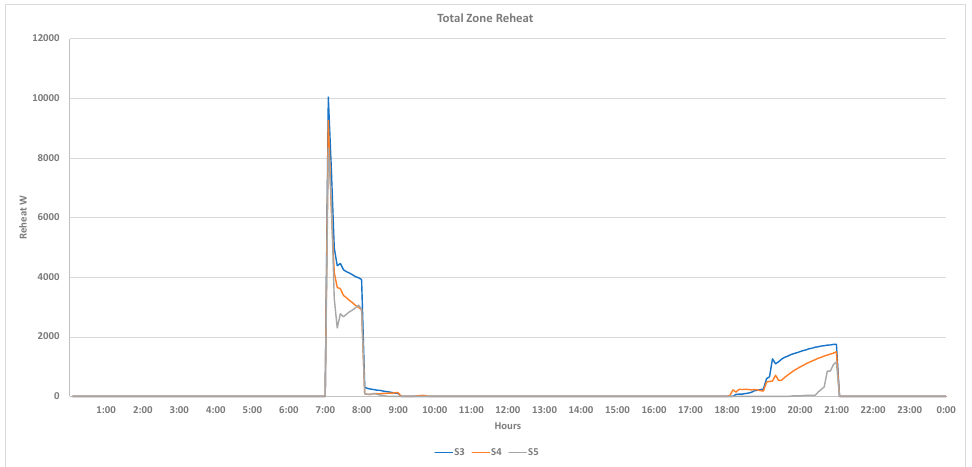
Figure 5. Total zone reheats when the strategies S3, S4, and S5 were applied.